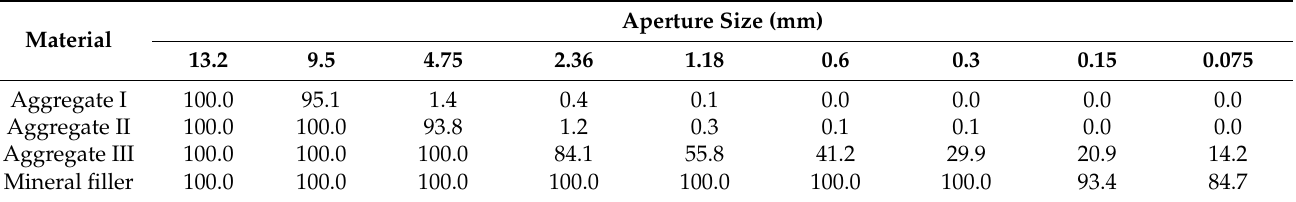
Table 4. Passing rate of